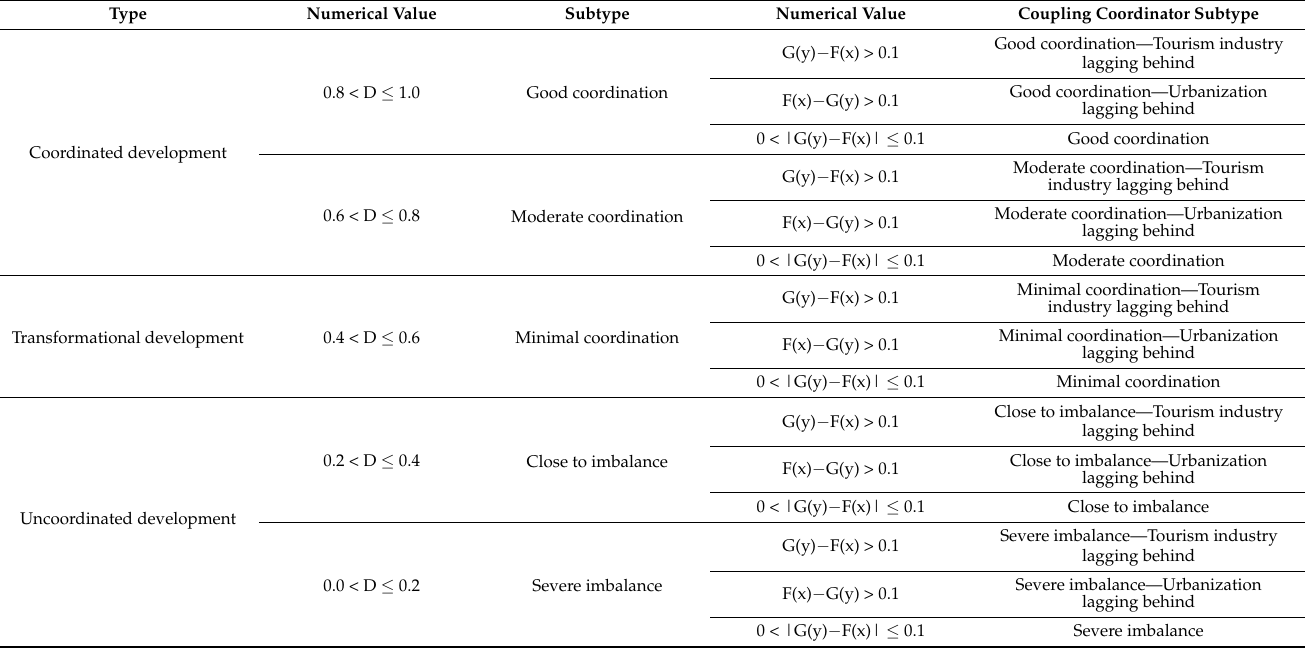
Table 3. The classification of coupling coordination